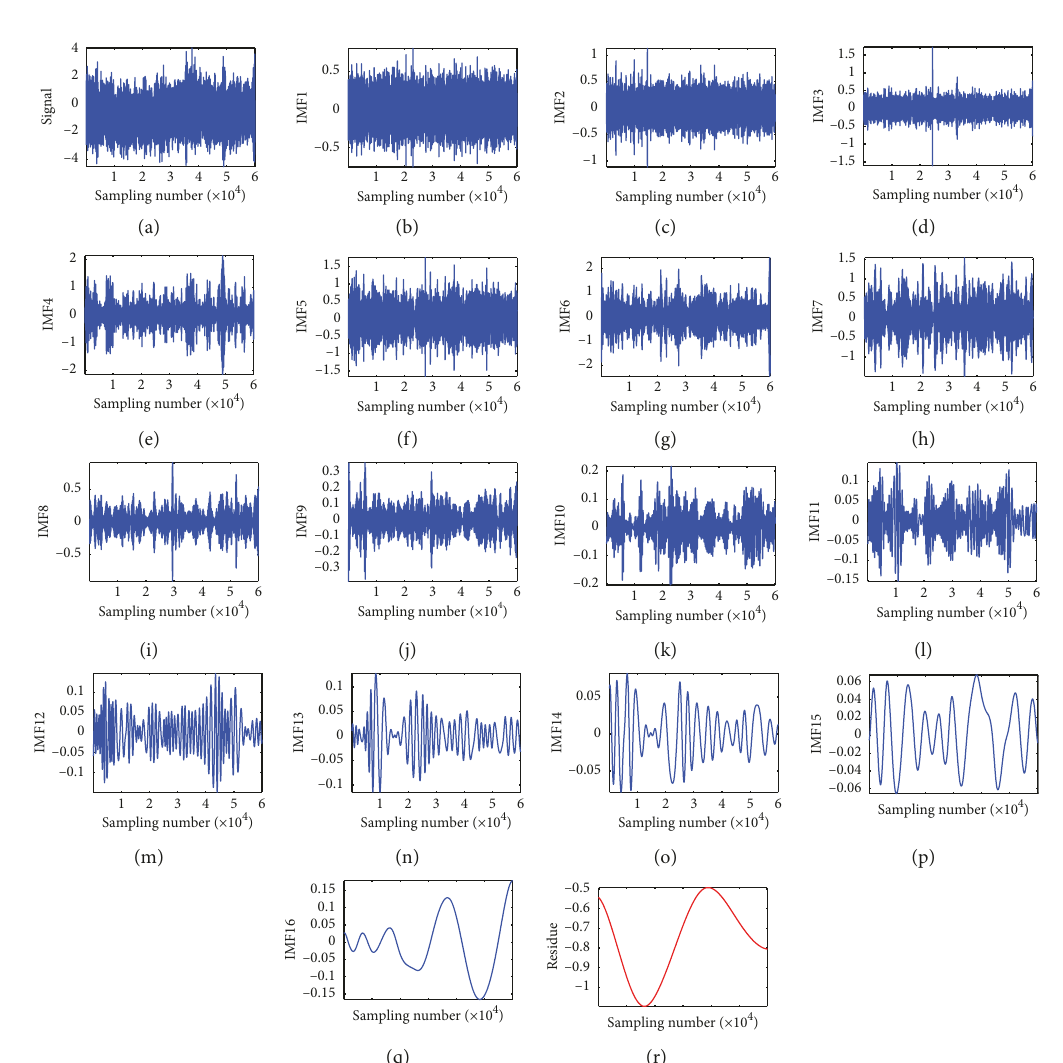
Figure 8: Components of intrinsic mode decomposition of an acceleration signal [28]: (a) acceleration signal, (b) IMF 1, (c) IMF 2, (d) IMF 3, (e) IMF 4, (f) IMF 5, (g) IMF 6, (h) IMF 7, (i) IMF 8, (j) IMF 9, (k) IMF 10, (l) IMF 11, (m) IMF 12, (n) IMF 13, (o) IMF 14, (p) IMF 15, (q) IMF 16, and (r) where a is a trigger level [5]. The identified first-order modal damping ratio corresponding to IMF1 shown in Figure 8 is presented in Figure 9 [28].